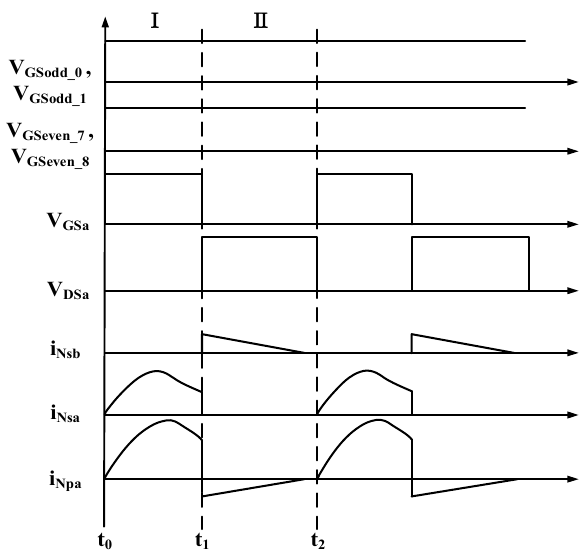
Figure 2. The theoretical waveforms in balancing process from V Bat1 to V Bat8 .